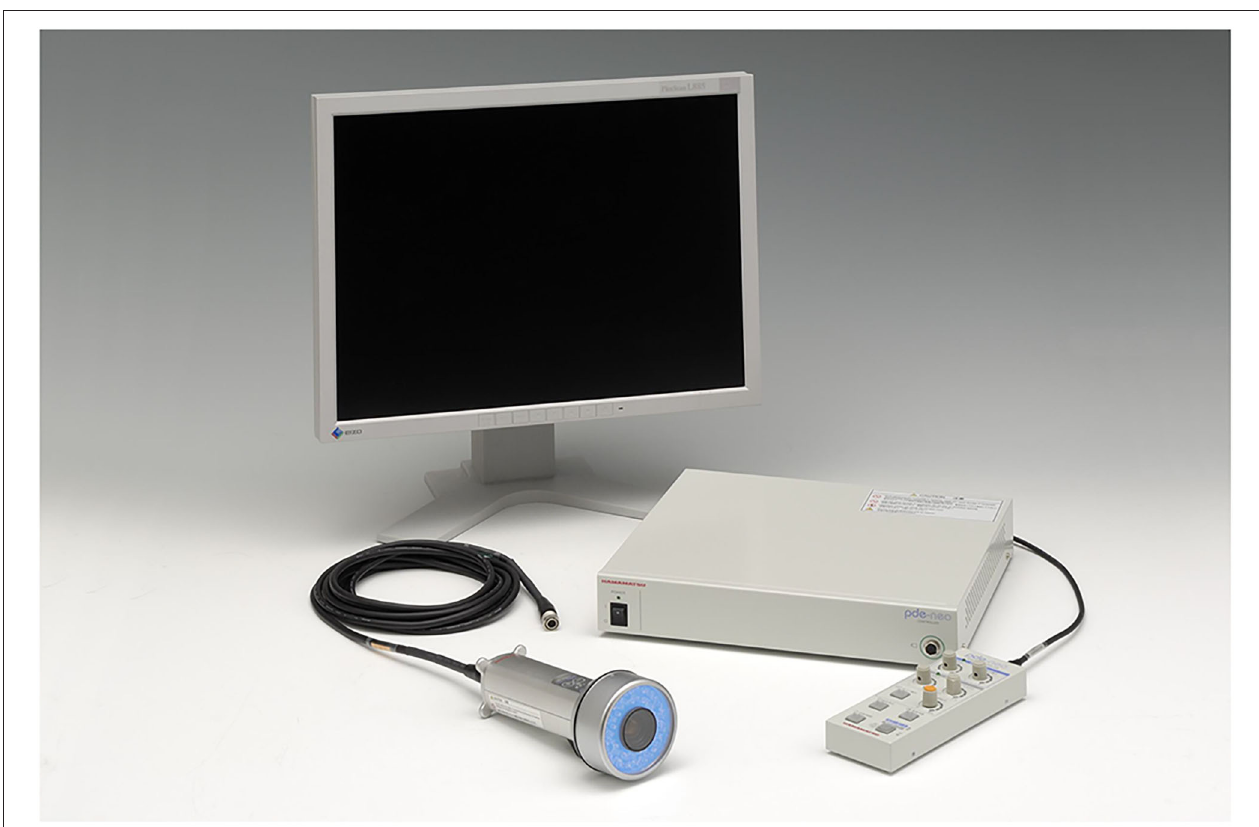
FIGURE 3 | The pde-neoII NIR fluorescence imager C10935-400 used to monitor extracted samples. This device projects 760-nm NIR EWL by LED and collects the fluorescence illumination at 830nm. This device is commercially sold to detect the sentinel lymph node in the breast cancer surgery with fluorescent light using indocyanine green. EWL, excitation wavelength; LED, light-emitting diode; NIR, near infrared.